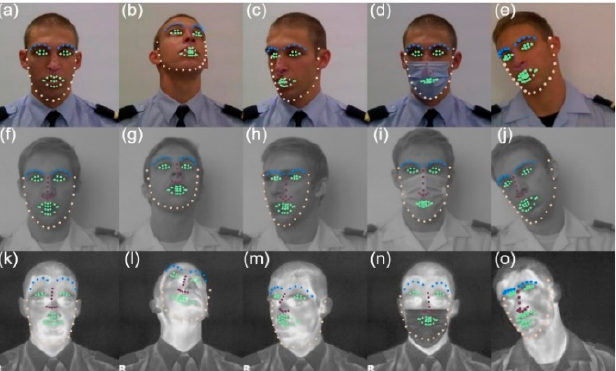
Figure 7. Results achieved by DLIB in the spectral bands of VIS ( a – e ), NIR ( f – j ) and LWIR ( k – o ). Yellow—jawline, green—eyes and mouth, purple—nose, blue—eyebrows.